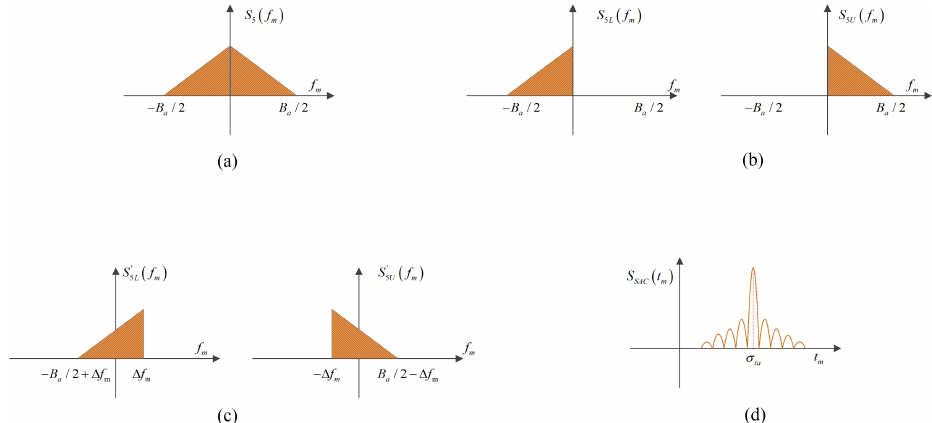
Figure 3. The principle of the SAC algorithm. ( a ) Spectrum. ( b ) Spectrum division. ( c ) Spectrum shifting. ( d ) Signal cross